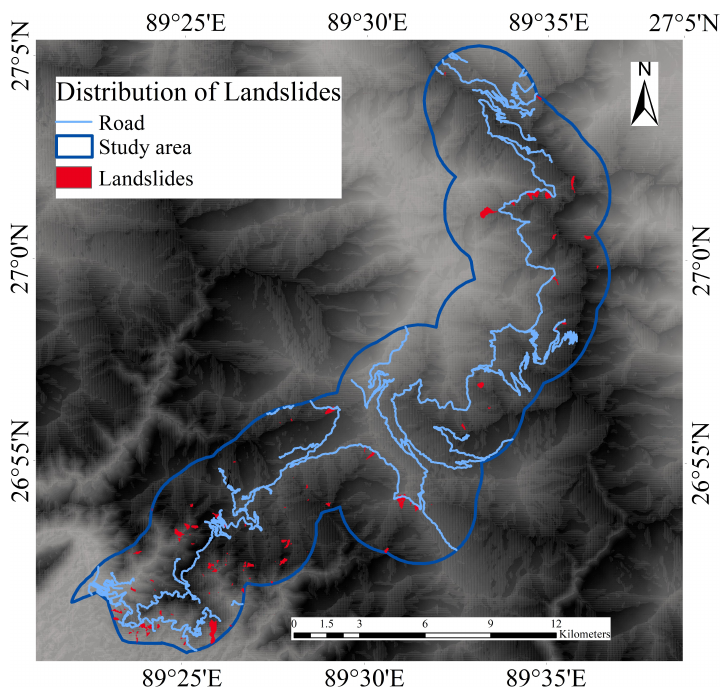
Figure 3. Landslide distribution along the Asian Highway